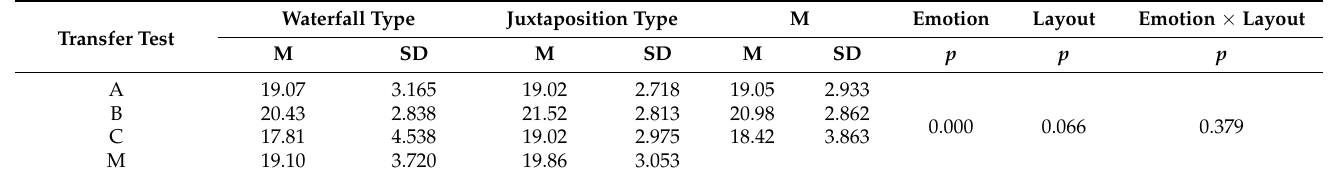
Table 3. Descriptive statistics and two-way ANOVA of the transfer test.